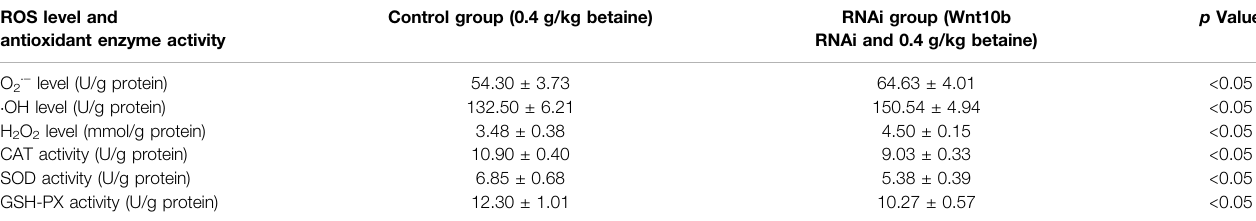
TABLE 5 | Effect of Wnt10b RNA interference on the level of ROS and activities of antioxidant enzymes in the liver of zebra fi sh. ROS level and antioxidant enzyme activity